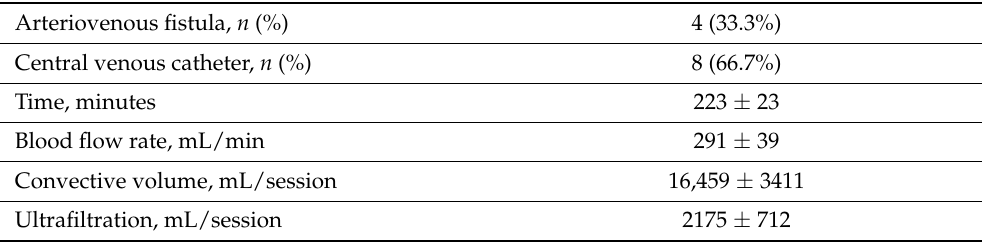
Table 5. Main features of 88 online HDF sessions using PMMA dialyzers in 12 patients. Arteriovenous fistula, n (%)